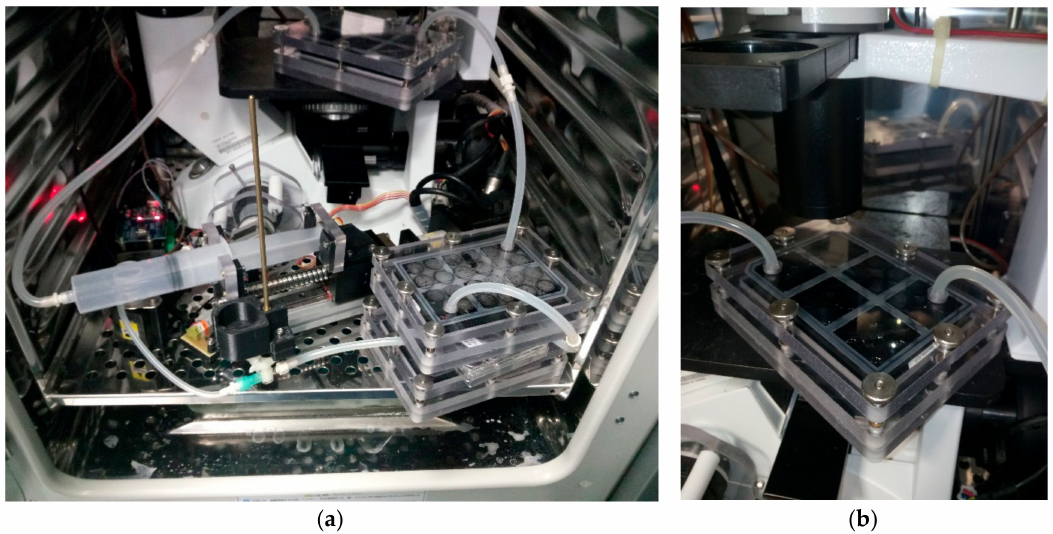
Figure A2. Lab-made dynamic cultivation system for pressure stimulation of cells on the tested material samples. The whole system in a cell incubator ( a ); detail of a cultivation chamber ( b ).